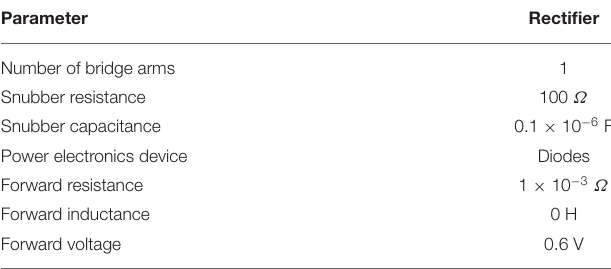
TABLE 3 | Parameters of simulated rectifier for down-frequency converter.